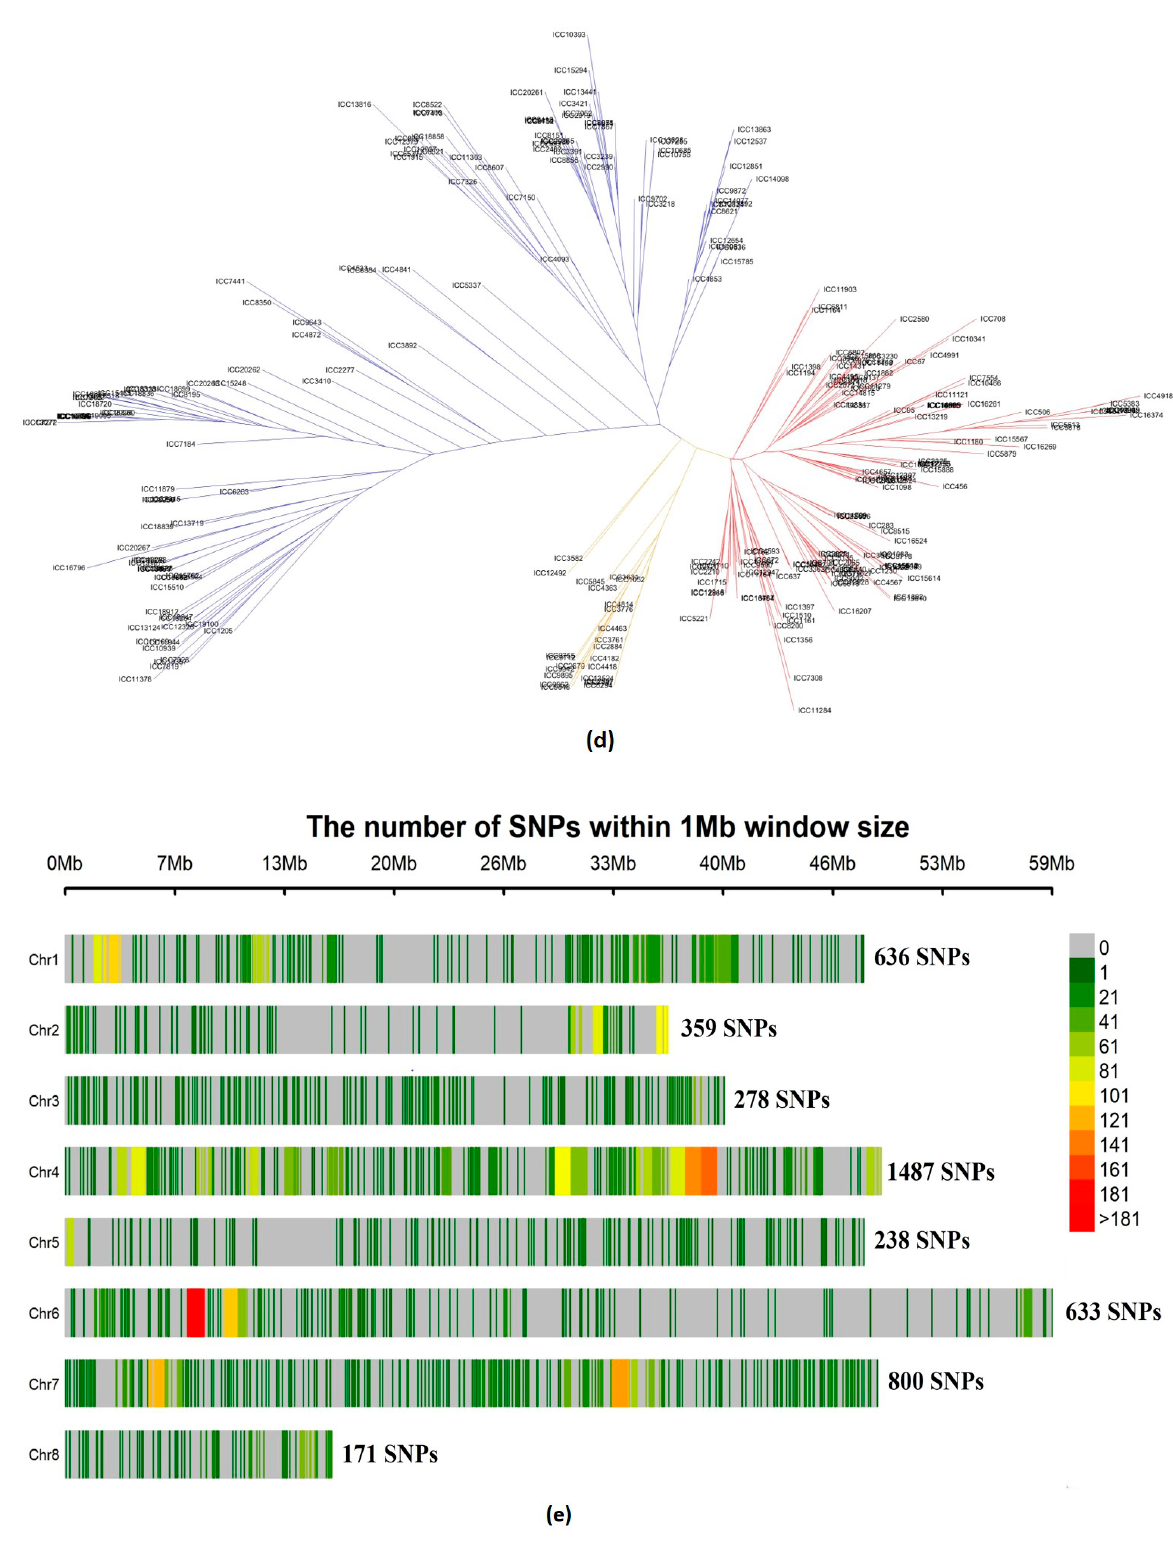
Figure 2. Population structure and phylogenetic analysis. ( a ) Evanno test for the optimum subpopulations (K = 3) using LnP(D) − derived ∆ K. ( b ) Population structure inferred into three subpopulations (SP), K = 3, based on ∆ K values. ( c ) PCA analysis with 4603 SNP markers. ( d ) Phylogenetic analysis using the neighbor-joining method grouped into three clusters (red, cluster 1; yellow, cluster 2; blue, cluster 3). ( e ) SNP density and distribution across chickpea genome.